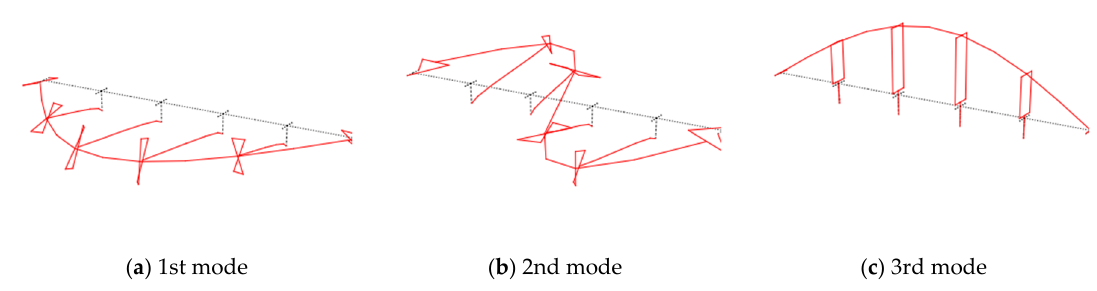
Figure 7. Mode shapes of the bridge: ( a ) 1st mode; ( b ) 2nd mode; ( c ) 3rd mode